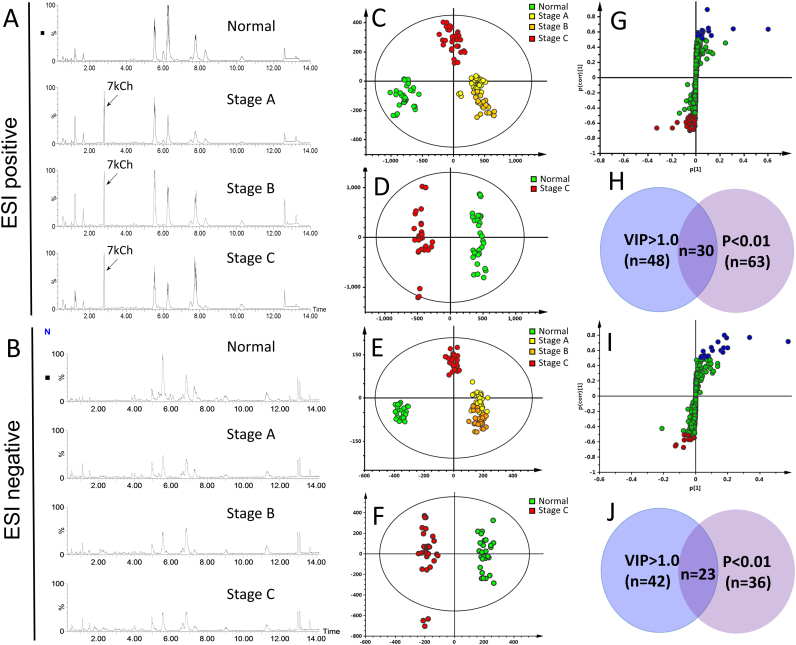
Liquid chromatography time-of-flight mass spectrometry-based lipidomics analysis of heart failure (HF) erythrocytes. Erythrocytes from normal control subjects and patients with stages A, B, and C were isolated for time-of-flight mass spectrometry analysis in electrospray ionization (ESI) positive and negative modes. Basal peak chromatograms of patients with HF at different stages and normal control subjects were obtained in ESI positive (A) and negative (B) modes, respectively. The molecular features were identified in samples (n = 39) by using Progenesis QI software and further data processing and statistical analysis were performed through SIMCA-P. Orthogonal partial least squares discriminant analysis (OPLS-DA) was performed for all samples, and the score plots for data sets obtained in ESI positive (C) and negative modes (E) are shown. The data for normal control and patients with stage C were reanalyzed using OPLS-DA, and the score plots for data sets obtained in ESI positive (D) and negative modes (F) are shown. Metabolites with significant differences in abundance in ESI positive and negative modes between normal control and patients with stage C are presented in S-plots (G and I), respectively. The Venn diagrams of the features obtained in ESI positive (VIP > 1.0 and p < 0.01) and ESI negative (VIP > 1.0 and p < 0.01) modes are shown in panels H and J, respectively. The normal control (n = 10), stage A (n = 10), stage B (n = 9), and stage C (n = 10) groups are marked in green, yellow, orange, and red, respectively. The ellipse shown in the model represents the Hotelling T2 with 95% confidence.